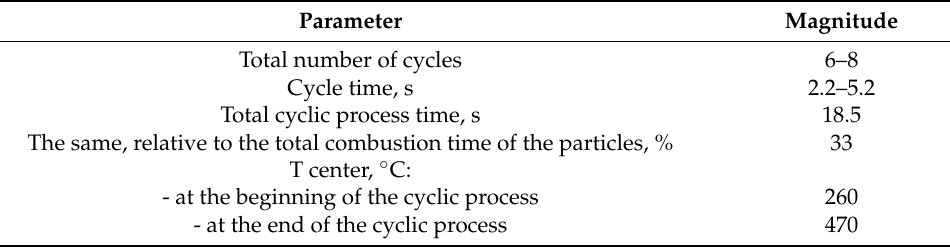
Table 2. Characteristics of the cyclic